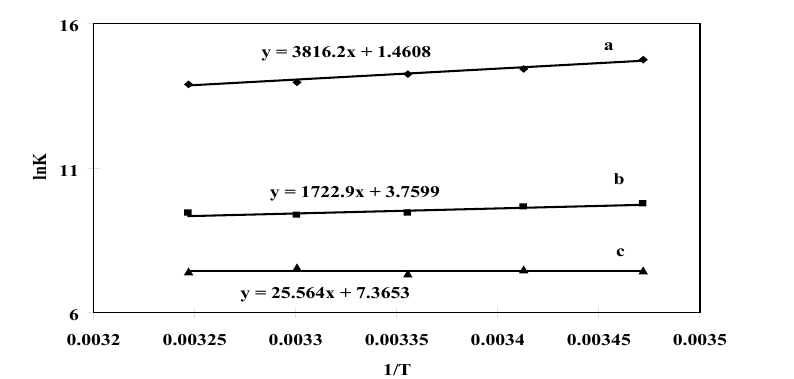
Figure 1. Effect of temperature on the hydrolysis of [Pd(DMPA)(H